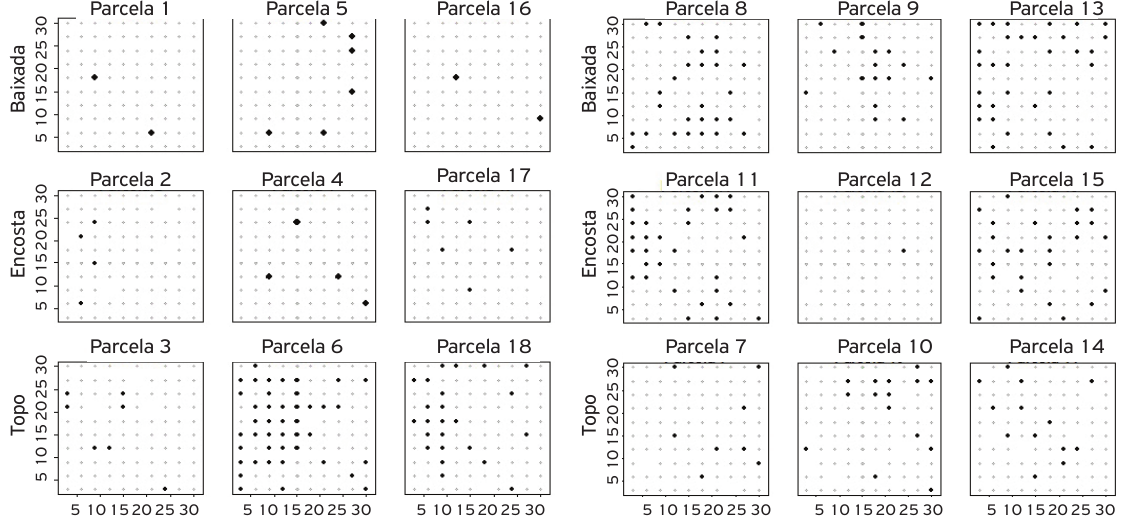
Figura 4. Distribuição do ataque de Heilipodus naevulus (Mannerheim, 1836) (metro) em áreas de plantio de clones de eucalipto, sob arranjo espacial de 3 x 3 m, no mês de janeiro/2009, nos talhões 21 (7 – 12, 16 – 18) e 29 (1 – 6, 13 – 15), subdivididos em baixada, encosta e topo. Barão de Cocais